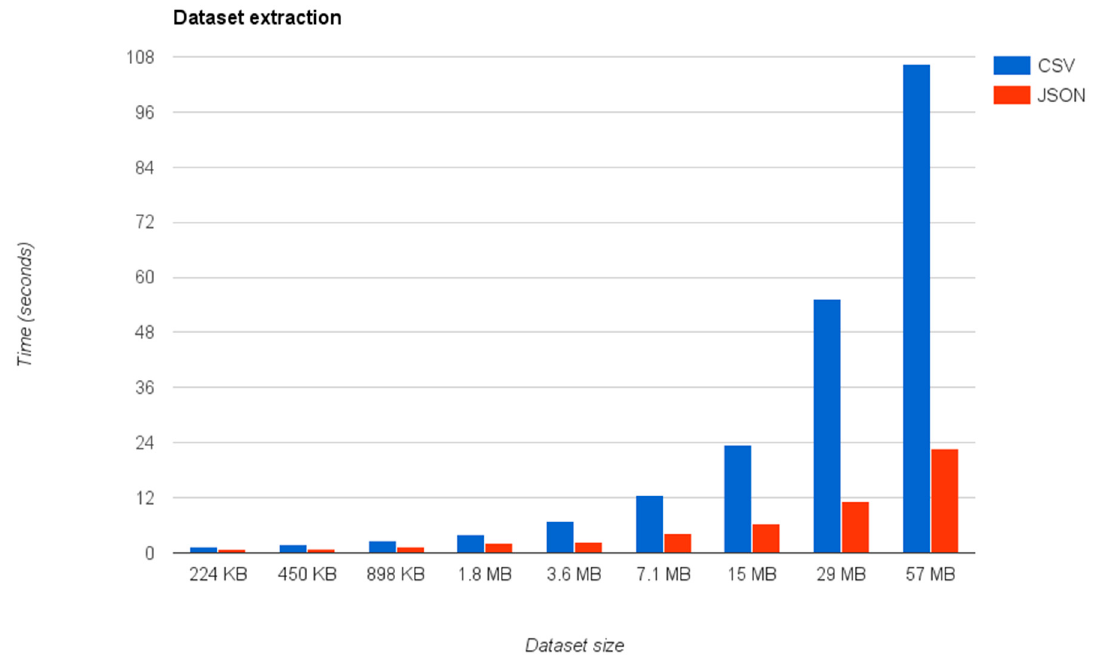
Figure 13. The graph shows the time required by the query mapper to extract a dataset depending on its size and its format (CSV or